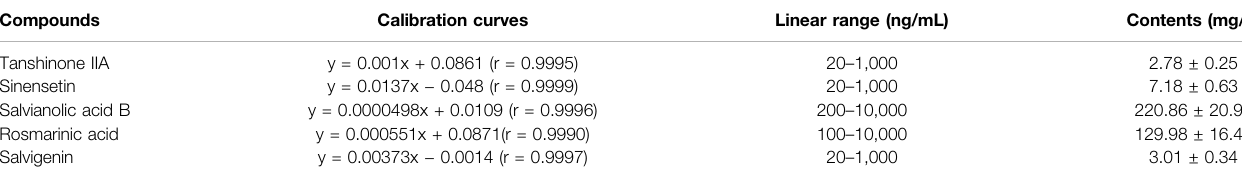
TABLE 3 | Calibration curves, linear ranges and determined contents of fi ve ef fi cacy markers in OSB extracts. Compounds Calibration